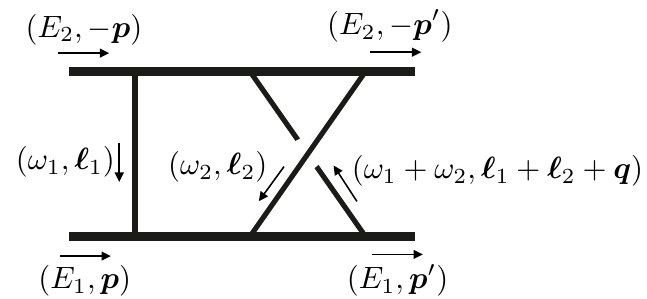
Figure 24 . The nonplanar double-box